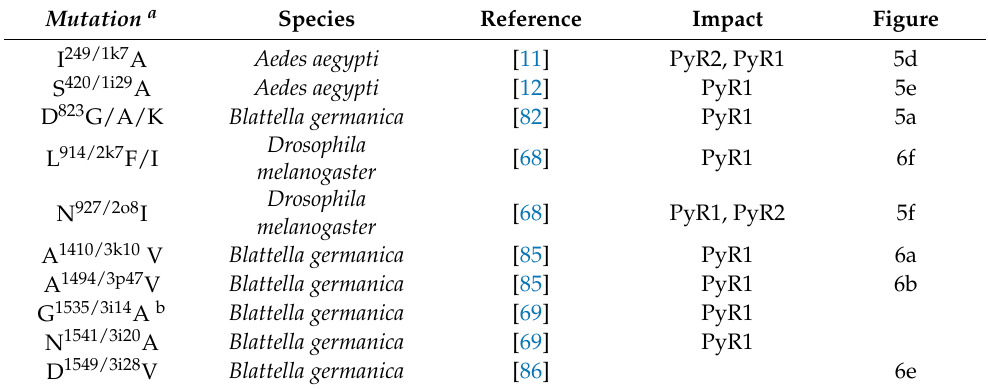
Table 4. Engineered mutations beyond PyR1 and PyR2 that affect the action of pyrethroids. Mutation a